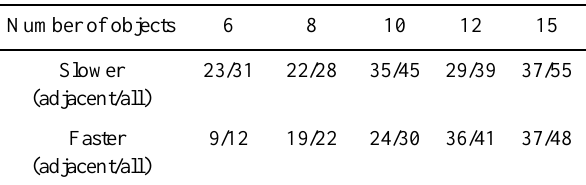
Table 2. Count for trials which were detected as adjacent digits and all false detected trials for all experimental